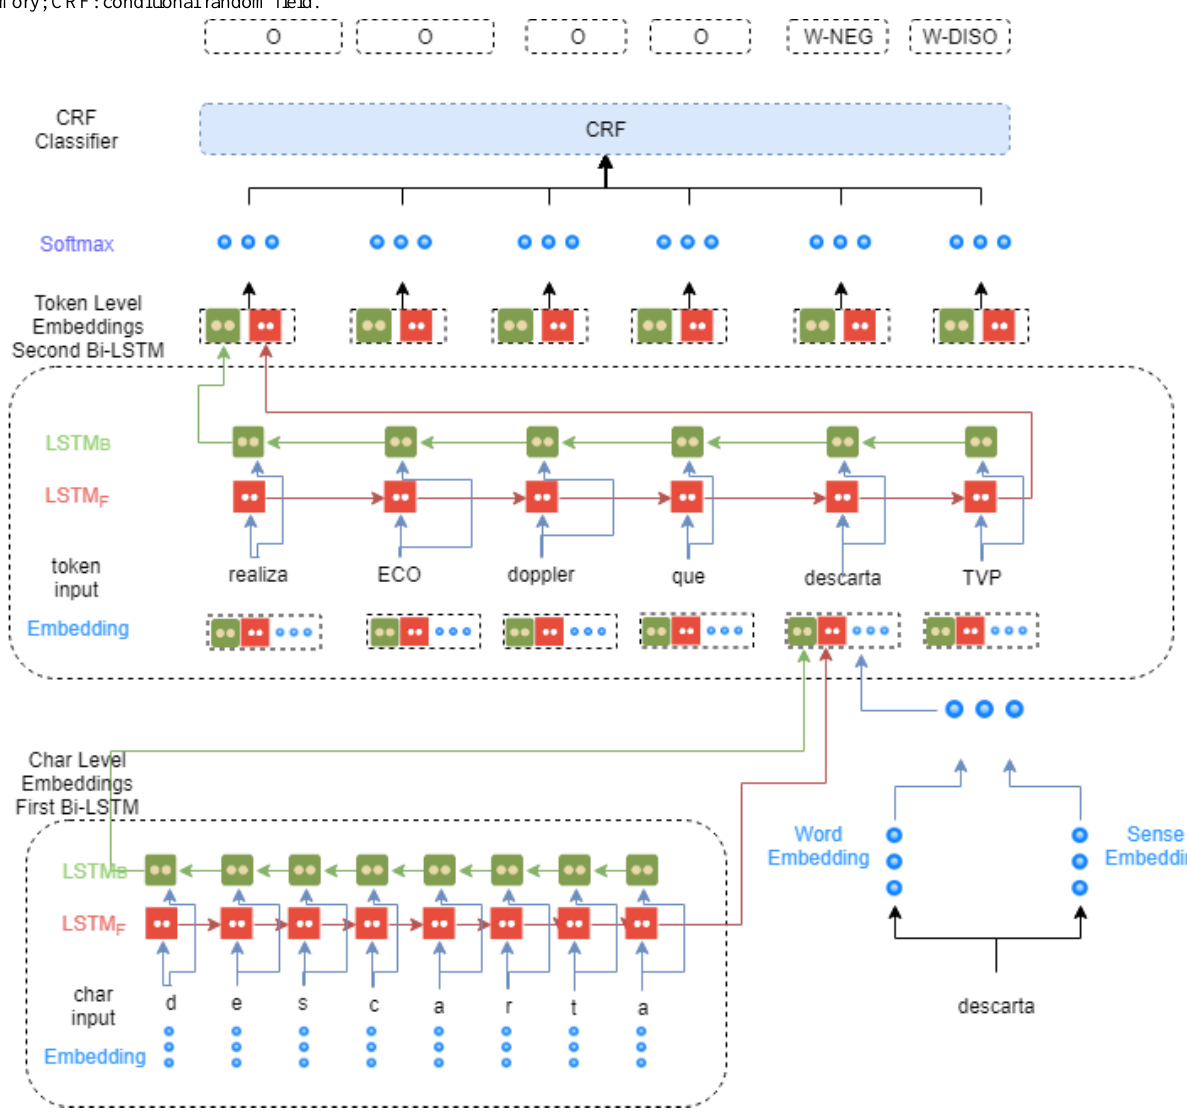
Figure 5. The architecture of the hybrid Bi-LSTM CRF model for negation and speculation recognition. Bi-LSTM: bidirectional long short-term memory; CRF: conditional random